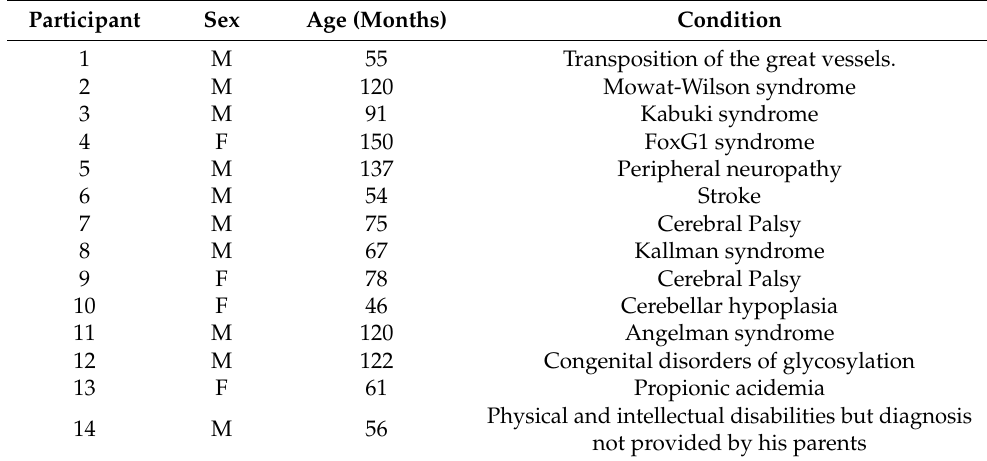
Table 2. Main descriptive characteristics of the